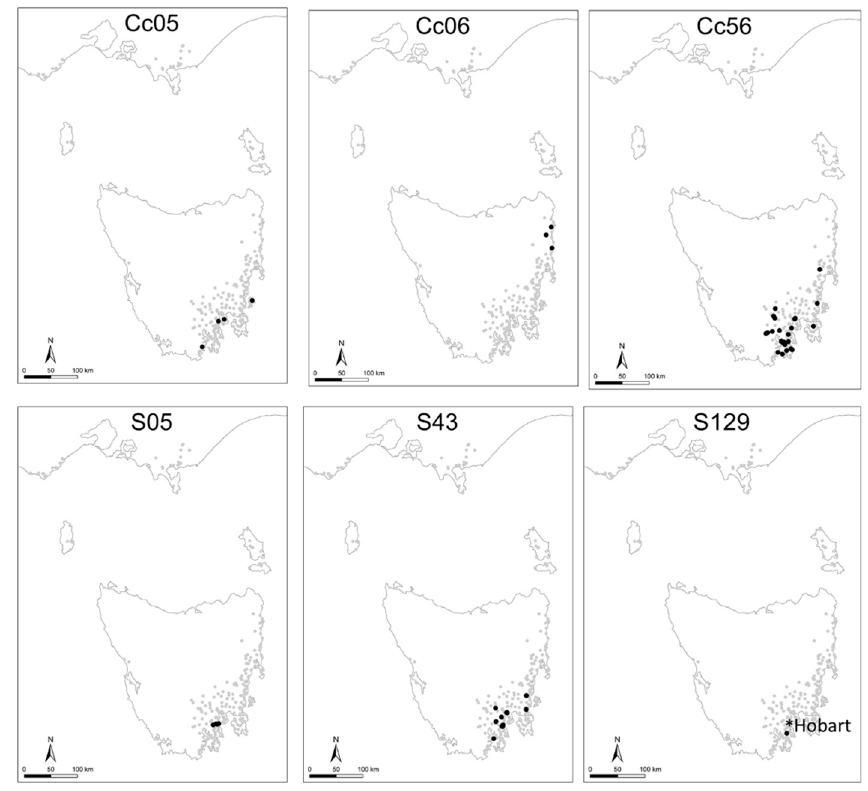
Figure 4. Native Australian distribution of six chloroplast haplotypes found in the Californian landrace of E. globulus of the central (Cc05, Cc06 and Cc56) and southern (S05, S43 and S129) types. These haplotypes are six of the nine haplotypes which have been found in native samples of E. globulus from Australia and have a localized distribution within eastern Tasmania. The location of Hobart is shown (*) on the S129 map.